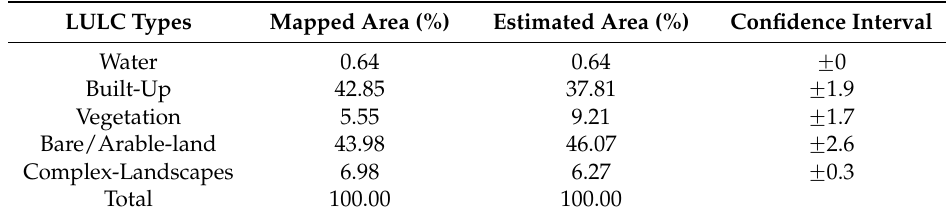
Table 9. Proportion of LULC category for 2014.